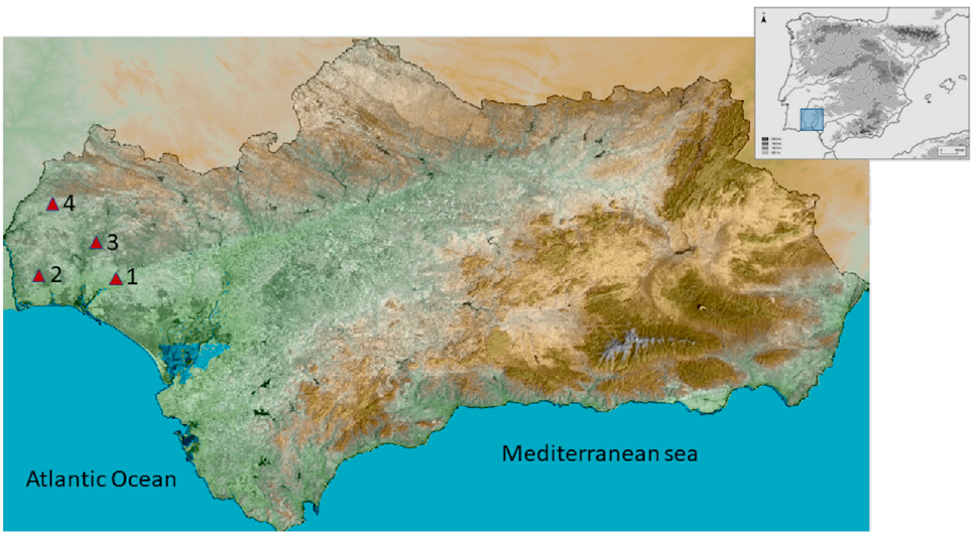
Figure 1. Sites analyzed in the Andévalo region (Andalusia, Spain). (1) El Moro tholos, (2) San Bartolomé tholos, (3) El Tejar dolmen, and (4) La Zarcita tholos. A spectral library was created containing the spectral signatures of these artifacts.